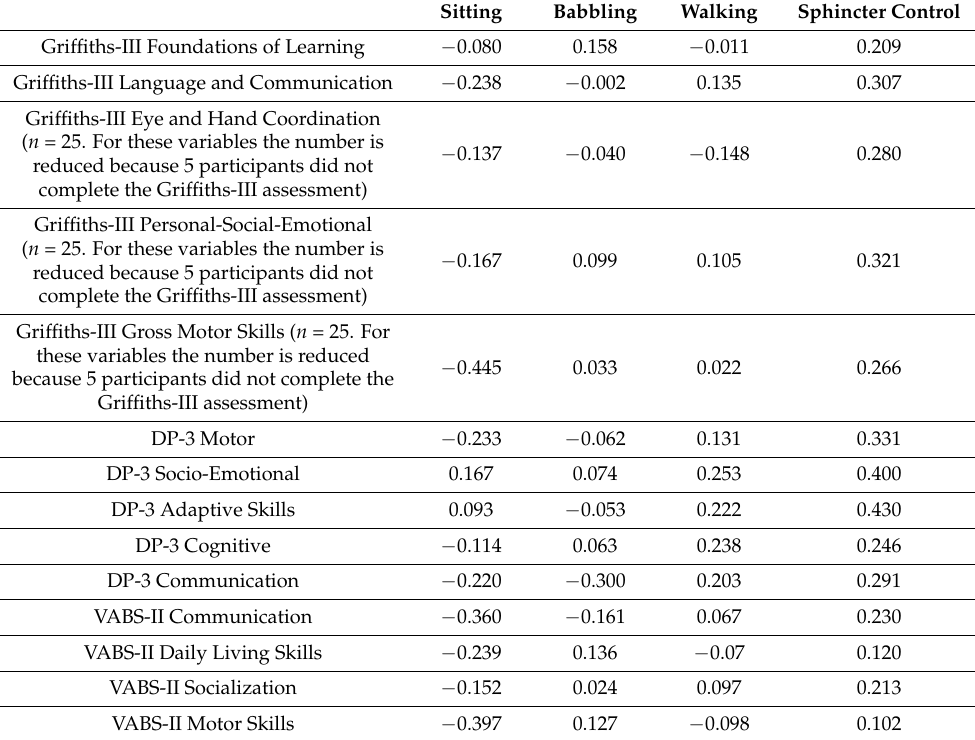
Table 4. Correlations between developmental milestones and cognitive, language, adaptive, and motor skills in the Preschooler group. N =